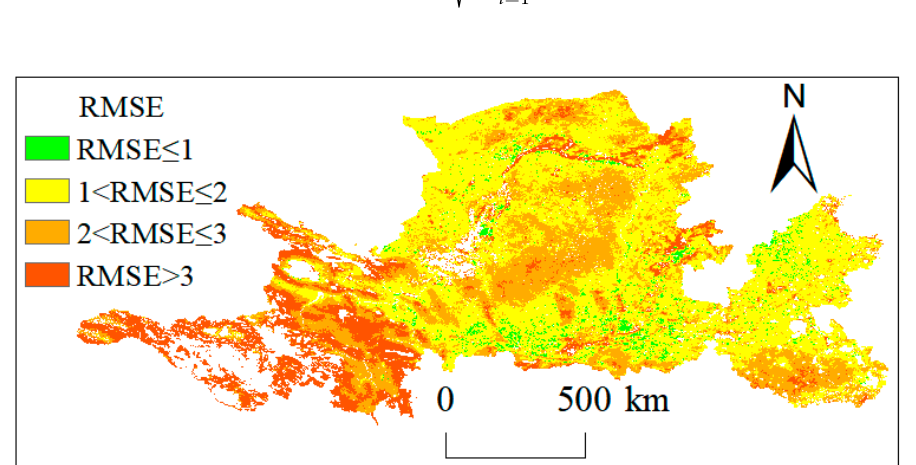
Figure 3. Root Mean Square Error (RMSE) distribution of the difference between ATC and MODIS LST.